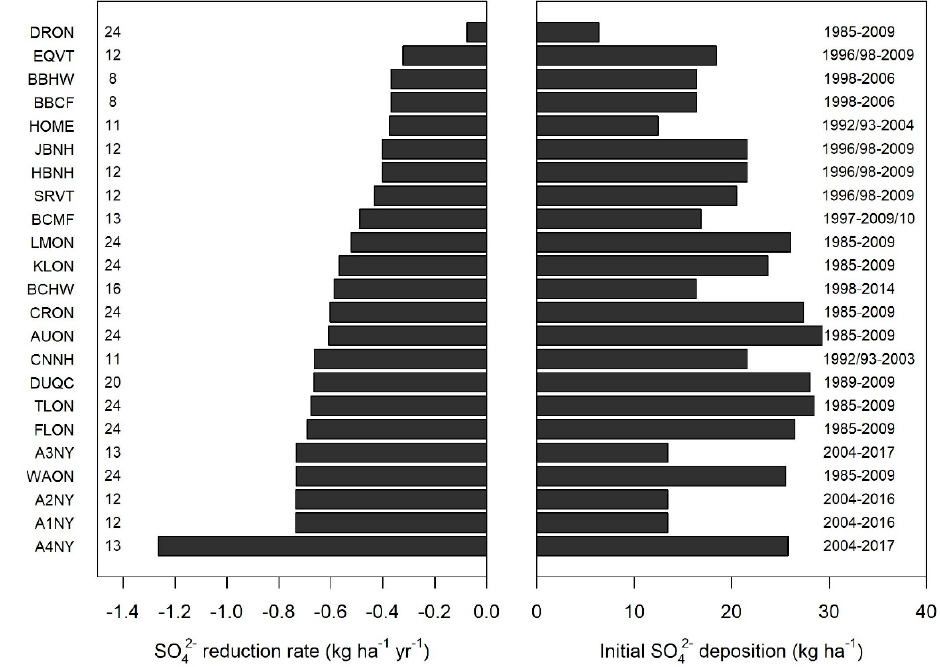
Figure 3. SO 42 − reduction rate and initial SO 42 − deposition at soil resampling sites in Eastern Canada and the Northeastern United States. Values on the left represent the number of recovery years for each site (i.e., number of years between initial and final soil sampling), and values on the right represent year of initial and final soil sampling.